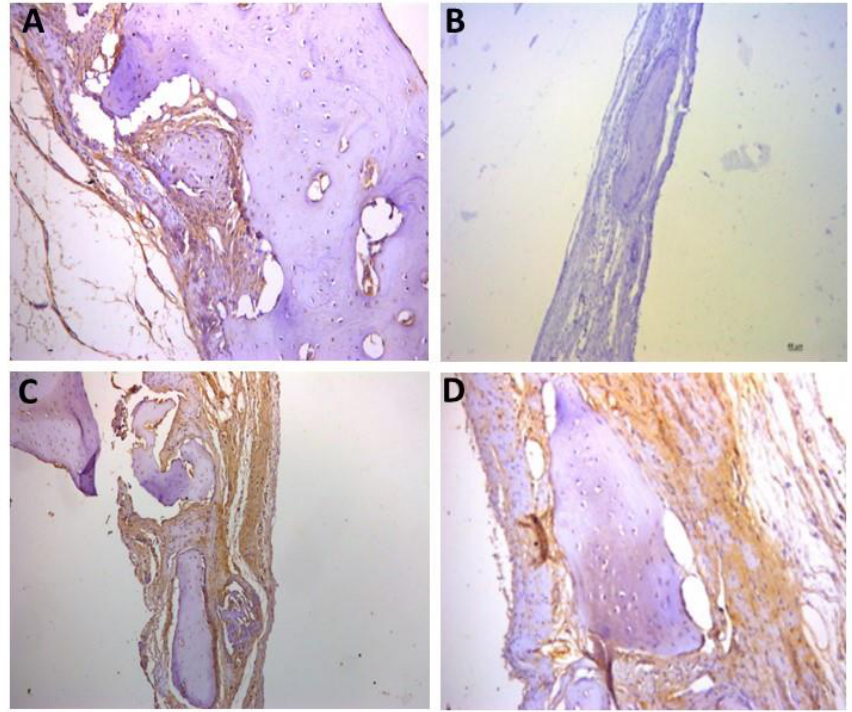
Figure 5. Representative immunohistochemistry images for IL1β staining. ( A ) control group; ( B ) negative control; ( C ) group 2 with marking considered (++); ( D ) group 7 with marking considered (++); the most observed staining pattern among the groups analyzed. Harris’ hematoxylin counterstained. Scale bar: 46 µm.